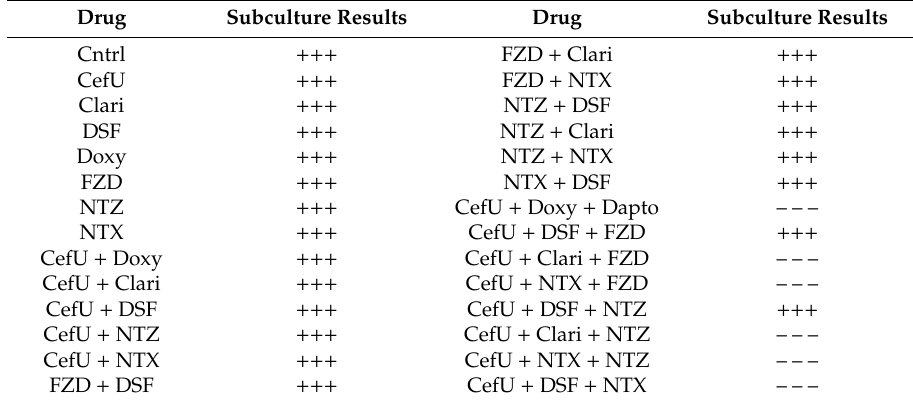
Table 4. Subculture experiment (after 3 weeks) of a 7-day-old stationary phase culture after a 7-day treatment. Subcultures were performed in triplicate for the single drugs, as well as for the two-drug controls and three-drug combination of interest.